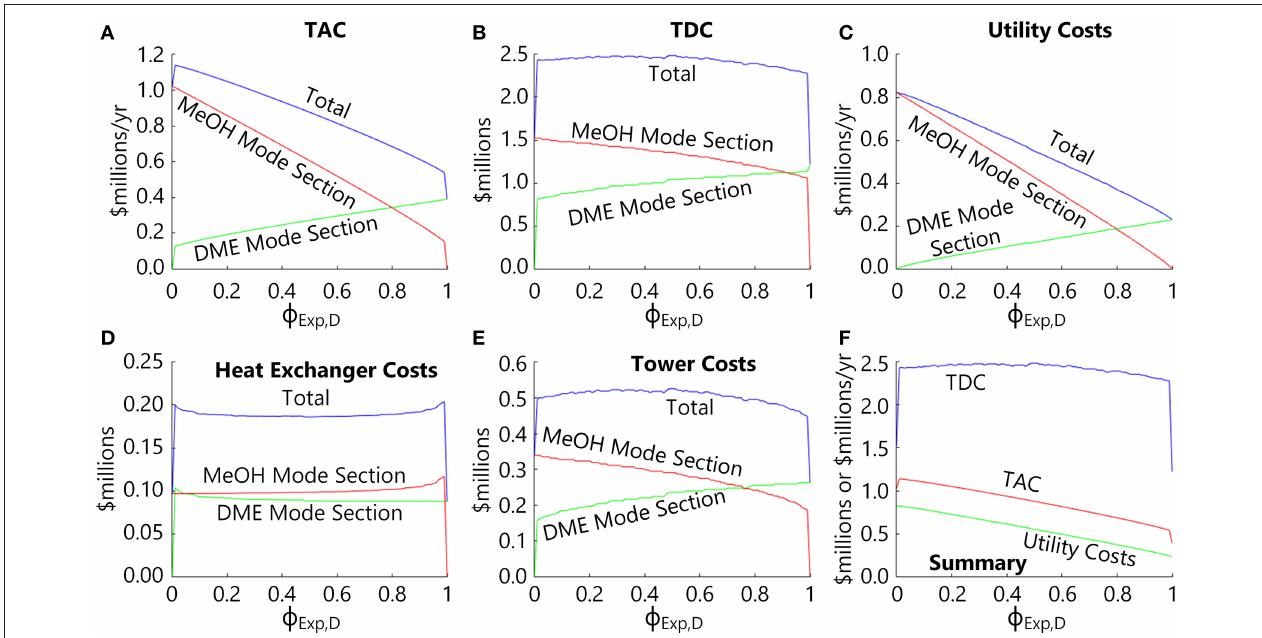
FIGURE 4 | The optimization results of Problem 1 for the Base Case as a function of φ Exp , D ). (A) The expected TAC for the Base Case ( TAC BaseCase , Exp ), the Methanol Mode section (